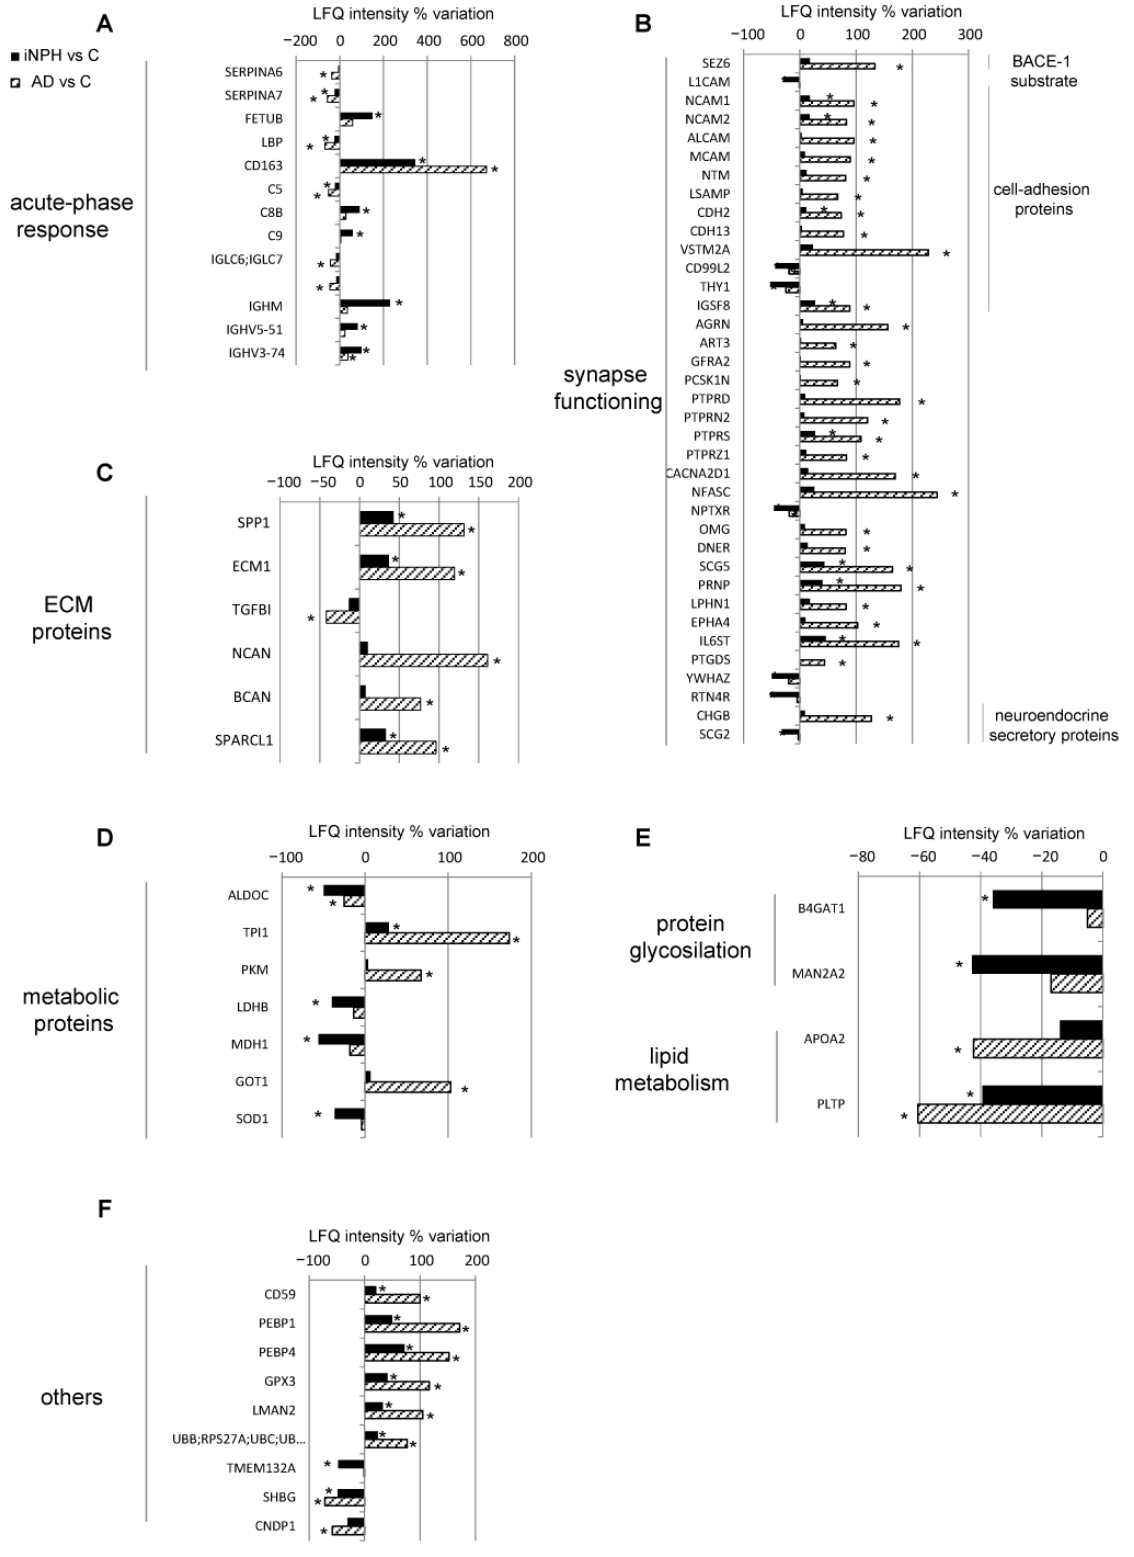
Figure 5. Differentially expressed CSF proteins in iNPH (black bars) and in AD (striped bars) patients compared to healthy cognitive subjects. Histograms of proteins with same trend levels in iNPH and AD (LFQ intensity% variation, * p -value < 0.05). Proteins were divided into panels according to their function ( A ) acute phase response ( B ) synapse func- tioning ( C ) extracellular matrix proteins ( D ) metabolic proteins ( E ) protein glycosylation, lipid transport ( F ) other